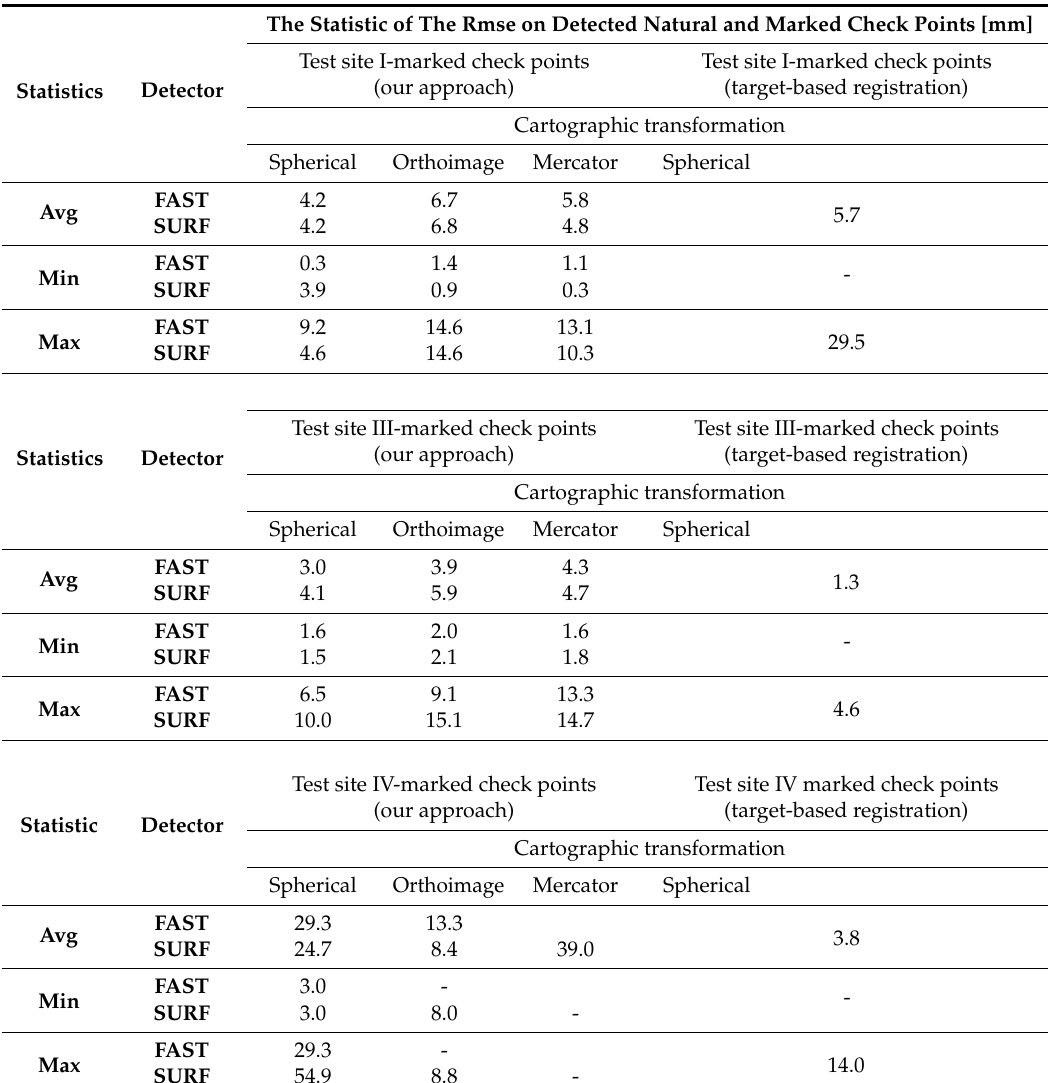
Table 12. Comparison of results of TLS reatser images orientation and the target-based registration